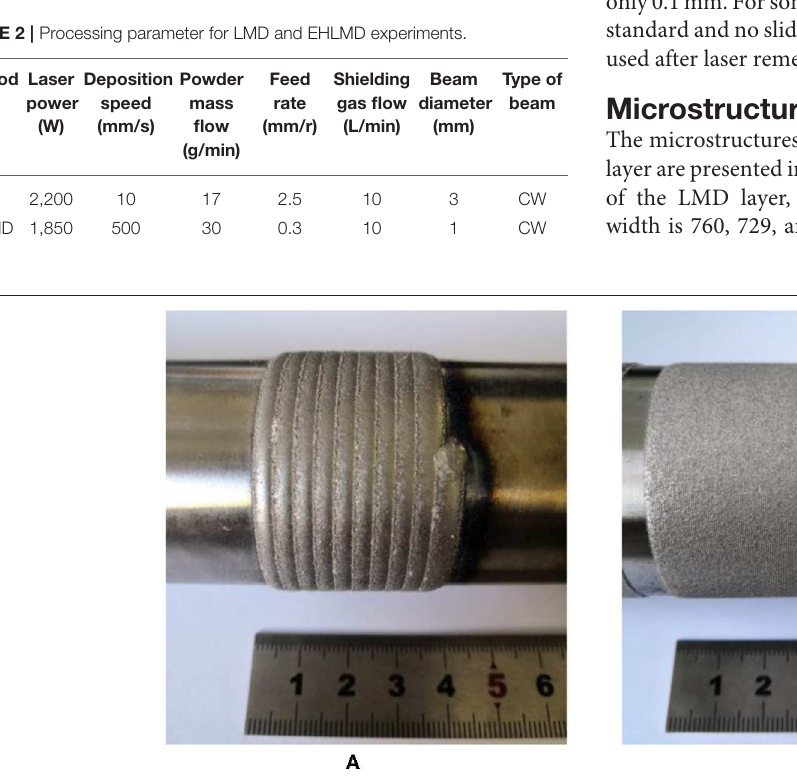
FIGURE 2 | The surface of (A) LMD single layer; (B) EHLMD single layer and polished layer.